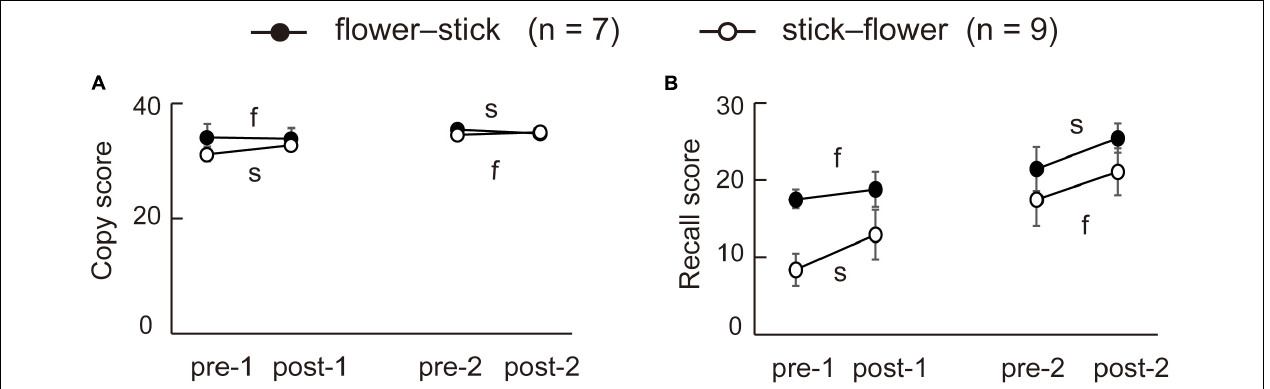
FIGURE 5 | Mean scores of the flower–stick ( n = 7) and stick–flower ( n = 9) SFA-treated subgroups in the Rey–Osterrieth complex figure copy (A) and recall (B) test. f, SFA treatments with flowers and leaves between pre- and post-tests; s, SFA treatments with sticks between pre- and